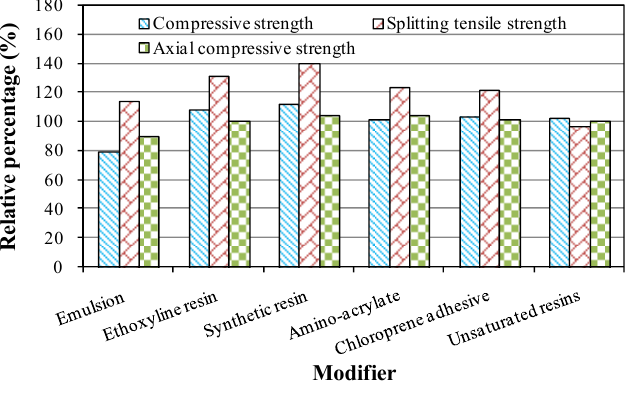
Figure 8. Effect of modifiers on mechanical properties.